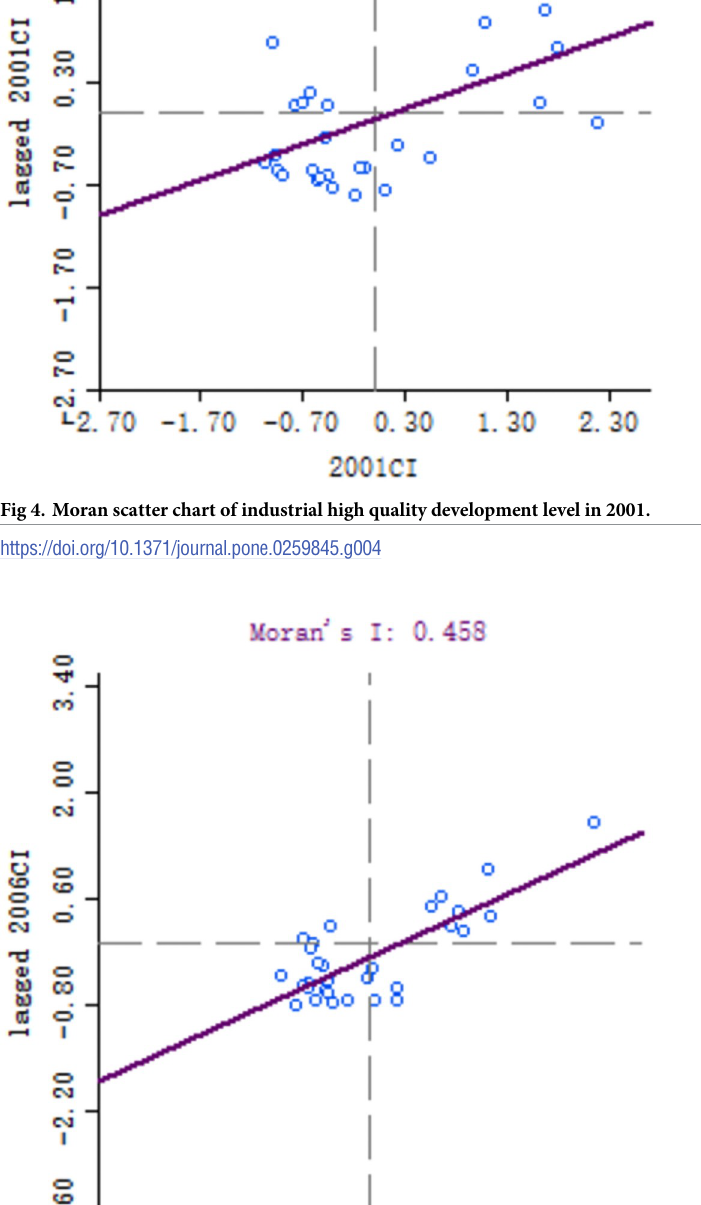
PLOS ONE | https://doi.org/10.1371/journal.pone.0259845 December31,